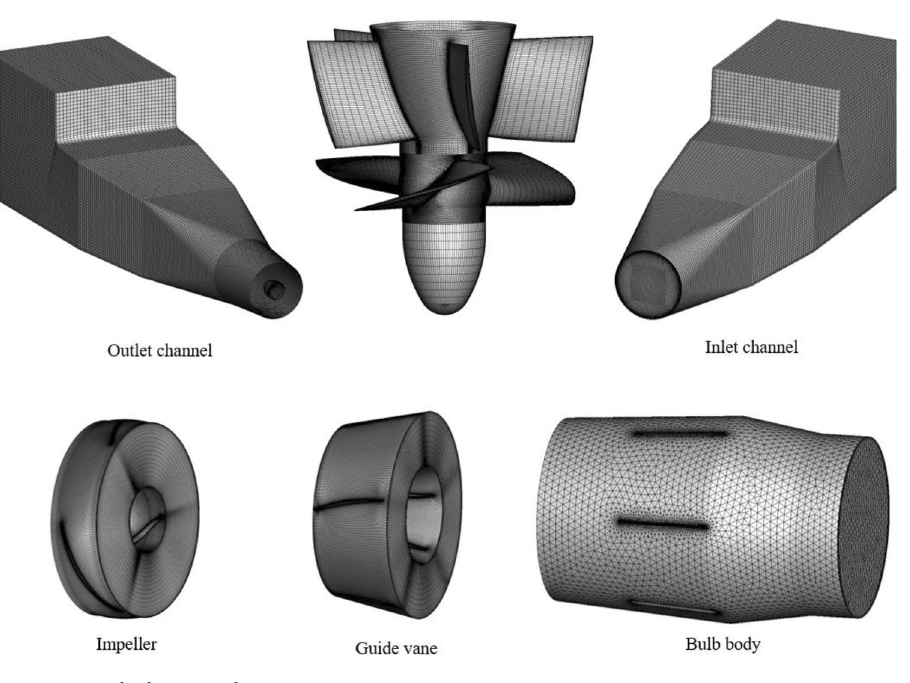
Figure 2. Calculation